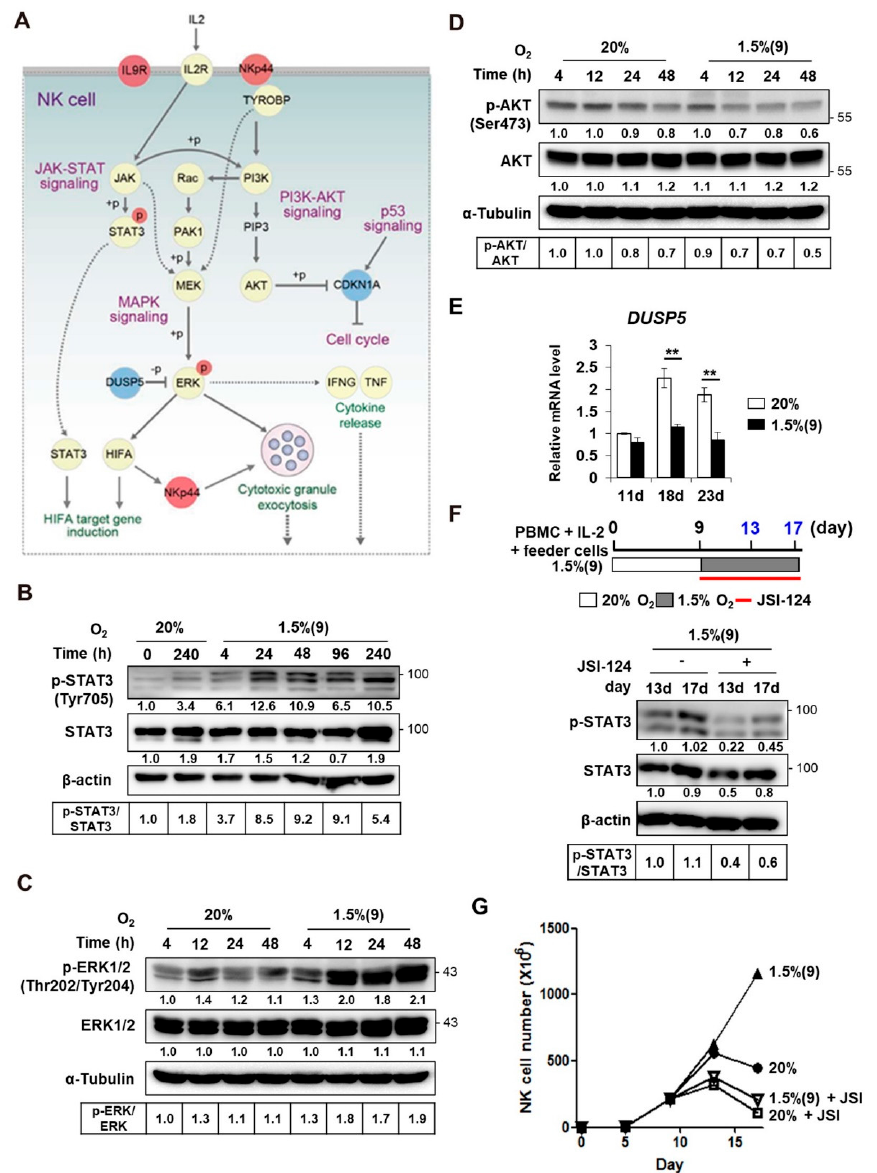
Figure 5. Enhanced proliferation of pre-activated hypoxic NK cells is related to ERK and STAT3 activity. ( A ) Network model includes interactions among the three major signaling pathways, STAT, ERK, and PI3K-AKT. The nodes and lines are as described in Figure 3E. Western blot analyses were performed to assess time-dependent changes of STAT3 ( B ), ERK ( C ), and AKT ( D ) phosphorylation in normoxic and hypoxic cultures of NK cells, following 9 days of culture in normoxia. Fold activation was calculated using densitometry, with β -actin or α -tubulin as a reference and is depicted under each band. The density of phospho-protein/total protein was calculated and provided below the band. ( E ) qRT-PCR analyses of DUSP5; NK cells in PBMCs were expanded with IL-2 and feeder cells under normoxic or hypoxic conditions and then isolated at the indicated days. The mRNA level of DUSP5 was normalized with respect to that of 18S rRNA. Data obtained from two independent experiments, each using PBMCs from different individual donors, are presented as the mean ± SEM. **, p < 0.01. ( F ) Upper , schematic representation, showing the treatment of STAT3 inhibitor JSI-124. NK cells were exposed to pO 2 of 1.5% in presence of 0.05 µ M JSI-124 after 9-day expansion in normoxia. Bottom , levels of p-STAT3 and STAT3 in normoxic and pre-activated hypoxic NK cells, in presence or absence of JSI-124 for 4 or 8 days (at 13 or 17 days). ( G ) The number of NK cells, cultured under normoxic or hypoxic conditions and treated with JSI-124, is plotted against